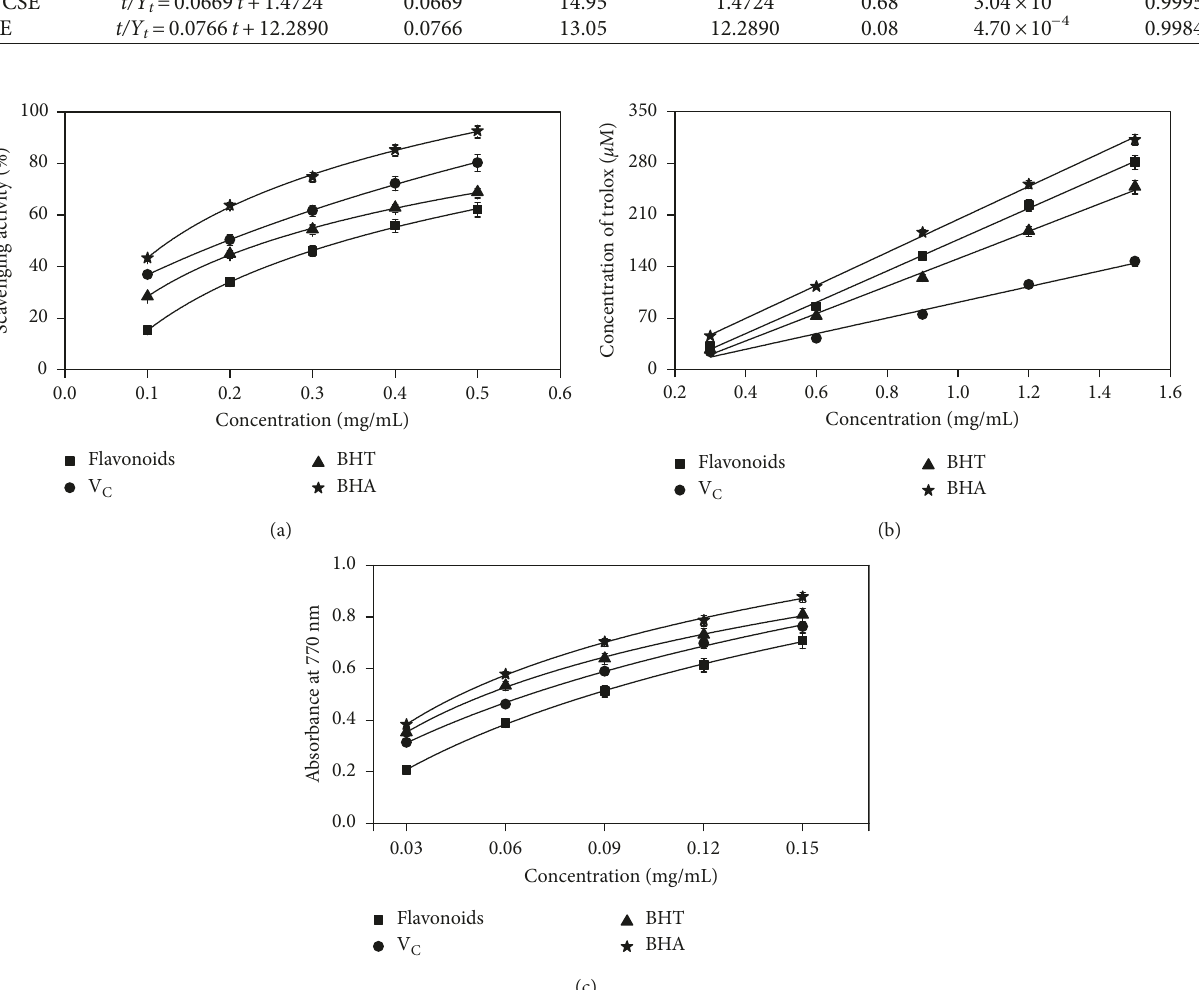
Figure 4: Antioxidant activity of flavonoids from C. camphora leaves. (a) DPPH radical-scavenging activity; (b) ferric-scavenging activity; (c) reducing